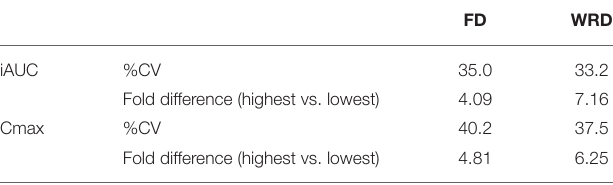
TABLE 2 | Observed variation in iAUC and Cmax in both dosing strategies.